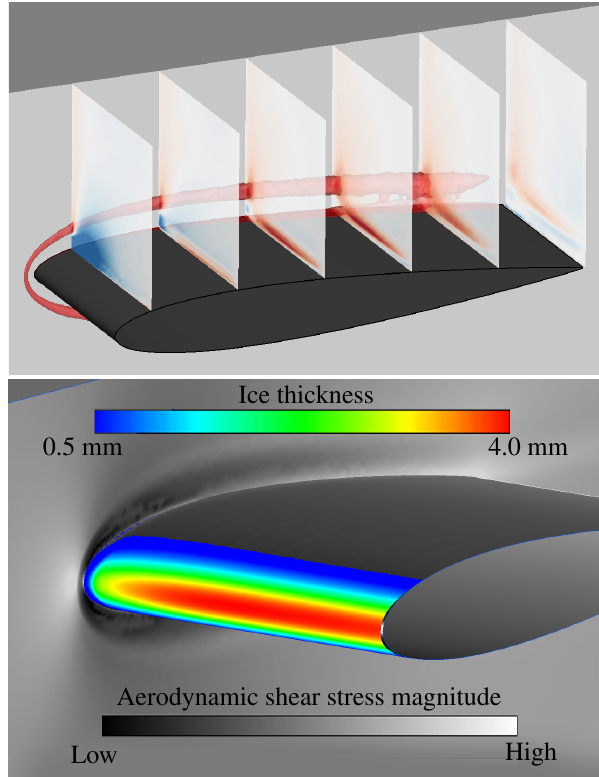
Figure 10. The junction flow between a NACA0012 airfoil ( c = 0 . 75m, α = 0 ◦ ) and wind-tunnel side wall creates a horseshoe vor- tex (upper image), which is altering the ice accretion (lower image). U ∞ = 40ms − 1 , T ∞ = − 10 ◦ C, LWC = 1gm − 3 and IWC = 0.